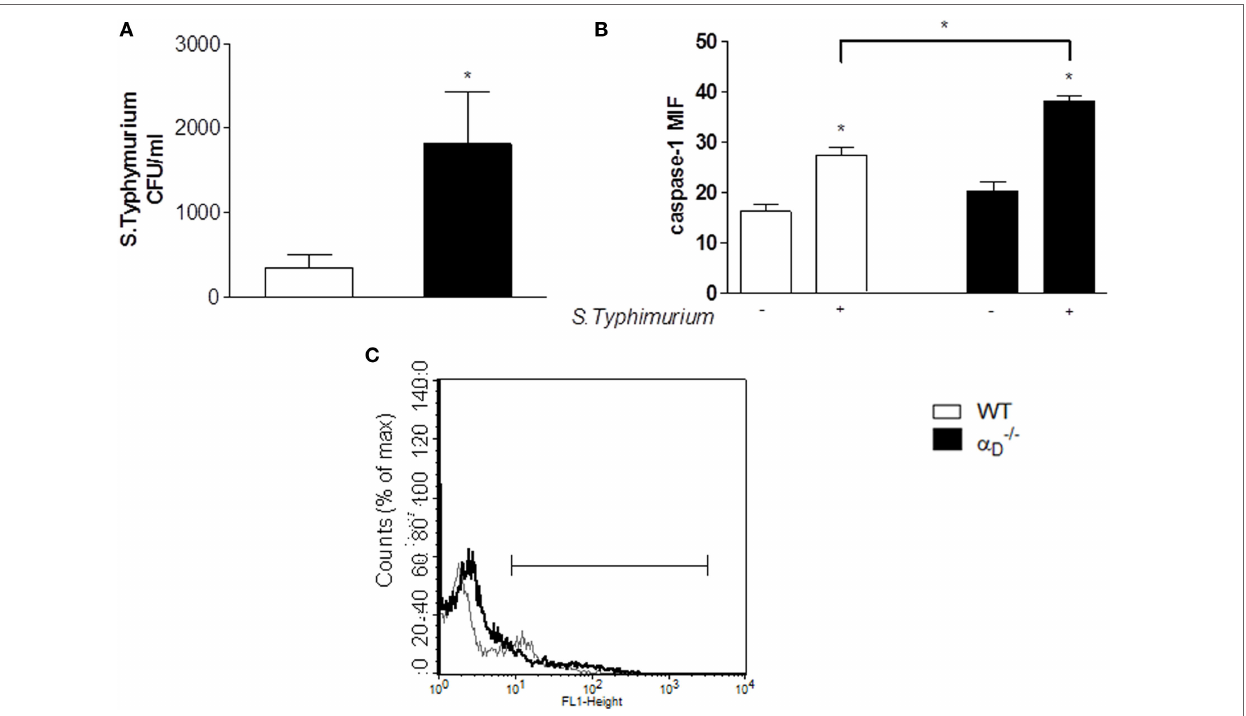
FIGURE 7 | Caspase-1 is increased in peritoneal leukocytes from Salmonella Typhimurium-infected mice. (A) Mice were infected with S. Typhimurium as in Figure 1 or were sham-infected, and 24h later peritoneal fluid was collected and cultured. There was increased growth of S. Typhimurium in the samples from α –/– D animals, similar to that in experiments shown in Figure 2 . (B,C) Cells from the peritoneal fluid samples were also analyzed for active caspase-1 by flow cytometry as described in Sections “Materials and Methods” and “Results” [mean fluorescence industry (MIF)]. Each bar indicates the mean (cid:6) SEM of determinations in samples from (cid:21) 4 animals. Significant differences ( p (cid:20) 0.05) between infected and sham-infected mice were indicated by asterisks, and between α –/– D and wild-type (WT) mice were indicated asterisks and bars. (C) Histogram indicating the active caspase-1 expression in peritoneal cells from WT- and α –/– D -infected mice is shown: thin gray line represents cells from WT-infected mice, and thick black line represents cells from α –/– D -infected mice. The Y -axis indicates cell number, and the X -axis indicates fluorescence